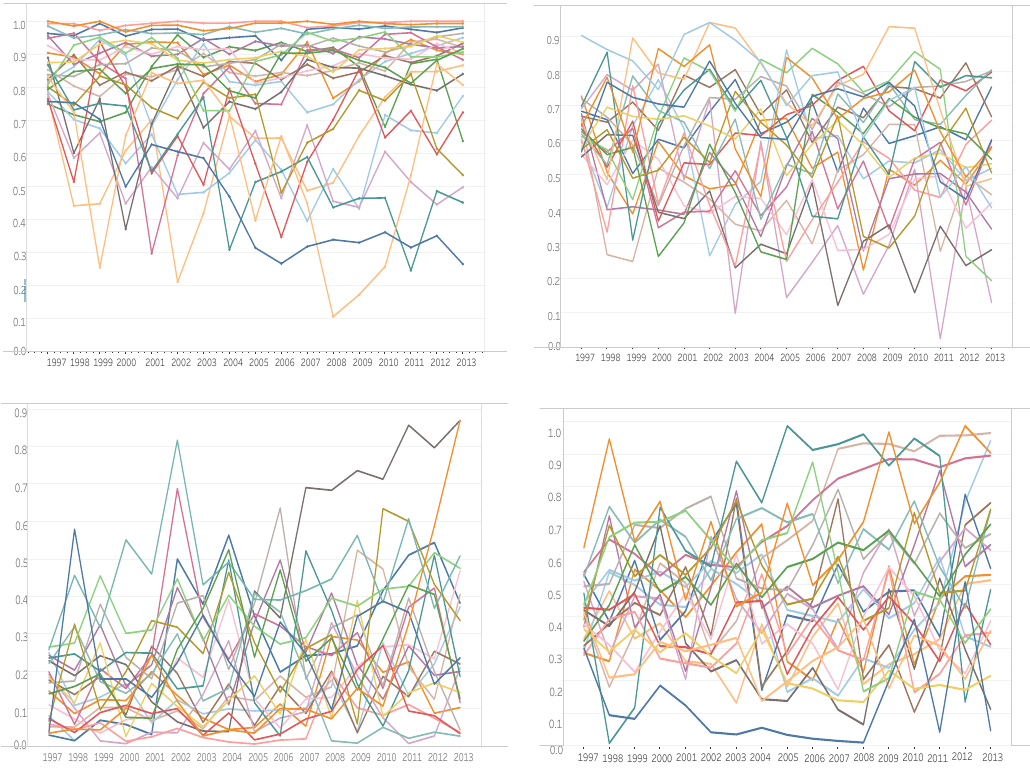
Figure 4. Behavior of the journals by quartiles (Q) in the list of mathematics. ( top-left ) Q1; ( top-right ) Q2; ( bottom-left ) Q3; and ( bottom-right )